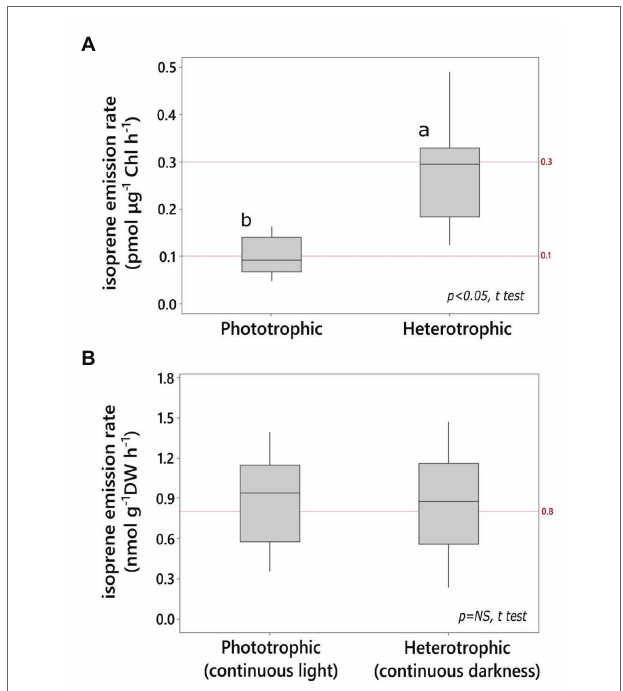
FIGURE 1 | Light and dark isoprene emission by Chlorella vulgaris (A) on chlorophyll (Chl) basis, (B) on culture dry weight (DW) basis. Emission in the light was measured from phototrophic cultures (minimal mineral medium). Emission in the dark was measured from heterotrophic cultures (glucose medium; N ≥ 6 technical replicates, t test, α =